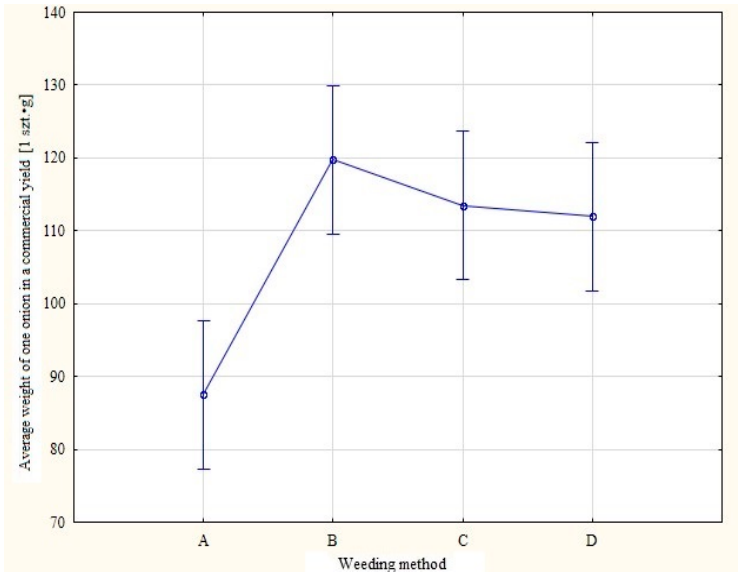
Figure 17. Expected marginal averages for 0.95 confidence intervals for the average weight of one onion in the commercial yield in 2017 (source: own work).